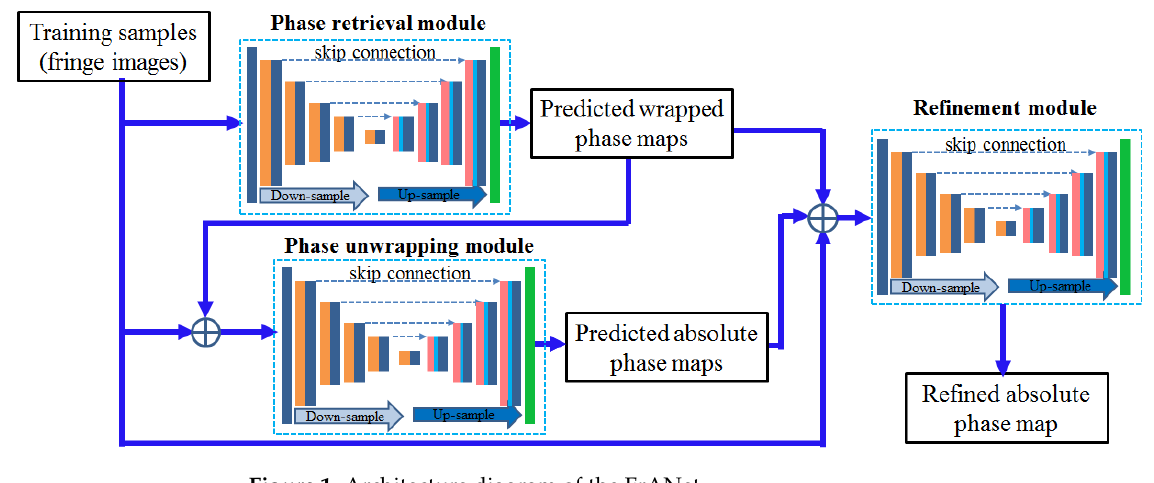
Figure 1. Architecture diagram of the FrANet.